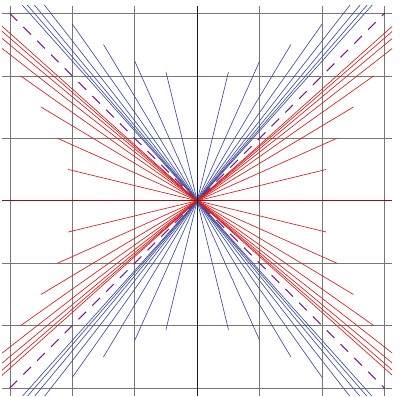
Figure 1: Spacelike ( blue ) and timelike ( red ) geodesics in (cid:2) 2